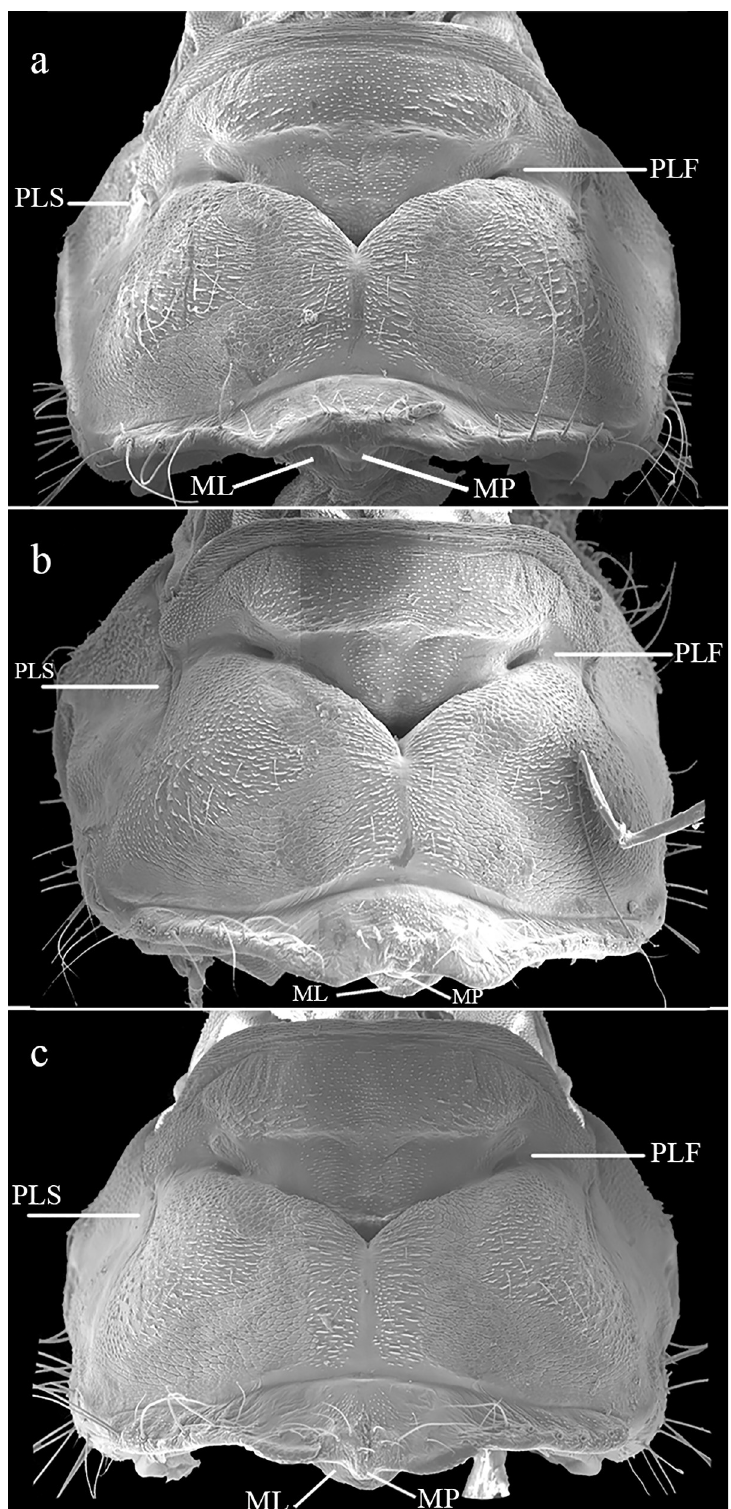
Fig 6. SEM images of dorsal pronotum, showing the main characters present on this structure. 6a–b. F . franciscoi ; 6c. F . sonia . PLS: notopleural suture; PLF: Lateral fossa; ML: Middle lobe of posterior lobe; MP: Rounded middle